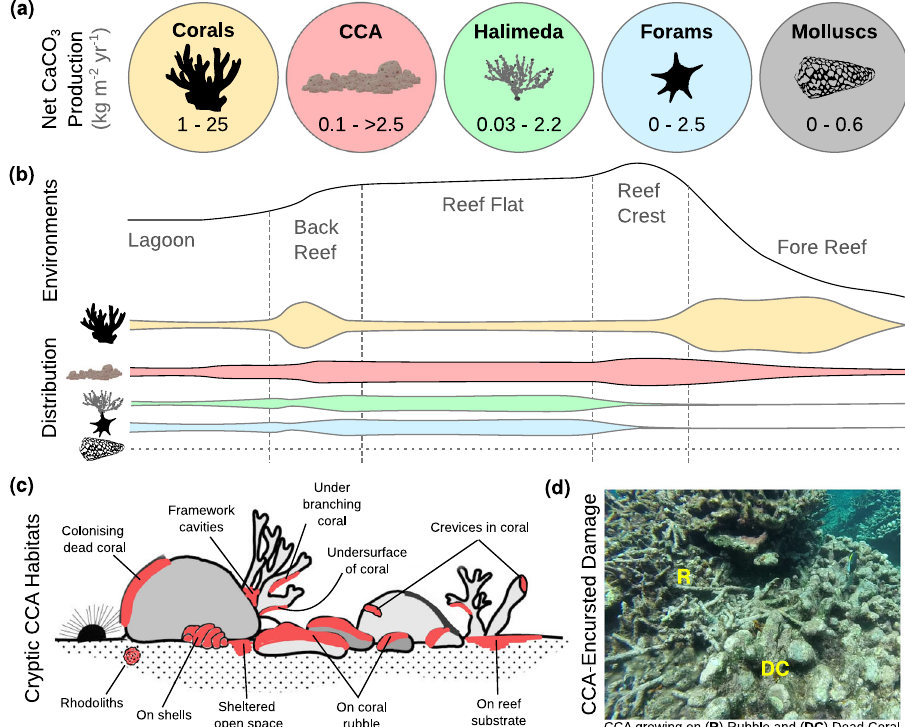
Fig. 1 Coral reef carbonate production and crustose coralline algae (CCA). a The contribution of the main groups of reef calci fi ers to carbonate budgets (corals, CCA, Halimeda spp., foraminifera (forams), and molluscs 5 ), along with b their approximate distribution across a range of reef environments based on observations by the authors of this study (molluscs are not straightforward because they can be mobile). c CCA may be found in numerous cryptic environments within reef habitats, and d commonly encrust dead coral and reef rubble after bleaching or storm